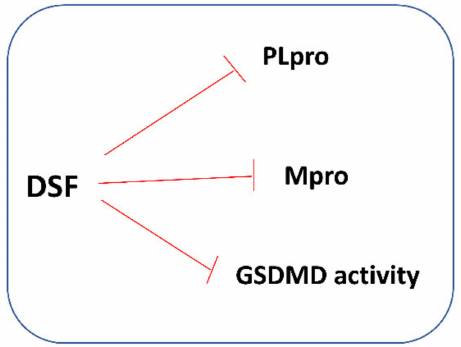
Figure 7. Some mechanisms of protective action of DSF against COVID-19. DSF inhibits the papain- like protease (PLpro) and main protease (Mpro) of SARS-CoV-2; both enzymes are essential to the replication and transcription of the virus. DSF can also affect GSDMD activity and in this way inhibit pyroptosis and cytokine